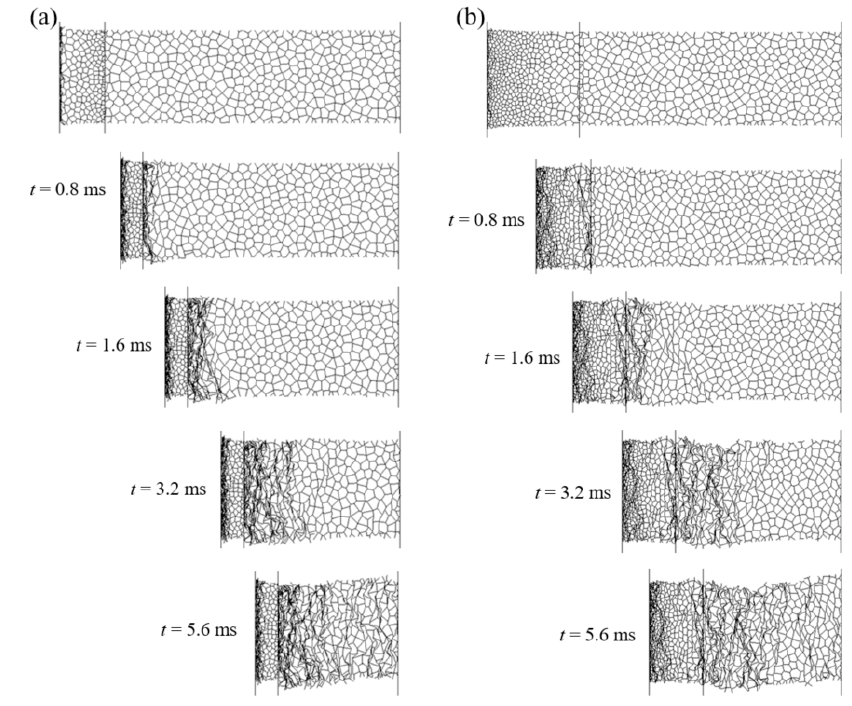
Figure 11. Deformation process of cellular sacrificial claddings obtained from the FE model: ( a ) PG-U cladding; ( b ) NG-U cladding.